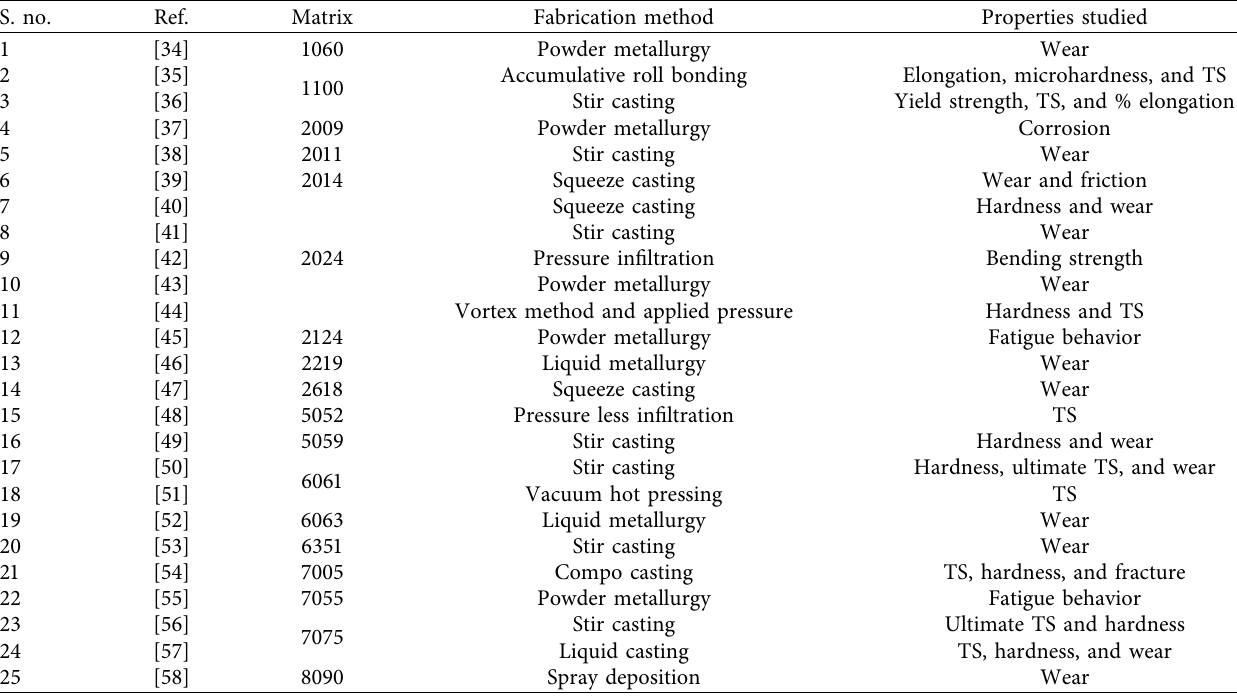
Table 5: Fabrication methods for various Al-MMCs.